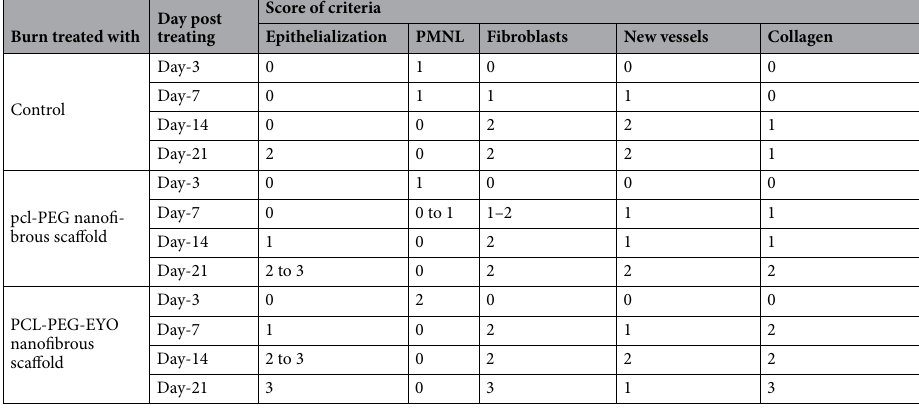
According to Table S1, the re-epithelialization process is scored between 0 to 4, with zero referred to the state of “no epithelialization” or “no signs of burn wound healing” and 4 referred to “full epithelialization”. Hence,